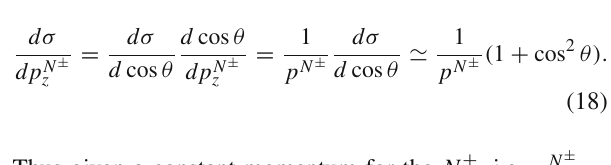
Fig. 21 The transverse momentum ( p T ) distributions of charged lep- tons(1stand2nd)atthemuoncolliderfor M N = 1TeV, Y N = 5 × 10 − 7 and center of mass energy 3.5 TeV. a and b represent the distributions